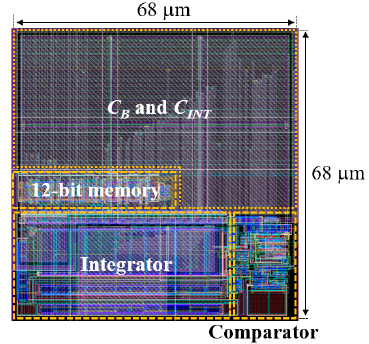
Figure 10. Mask layout of the unit cell circuit.